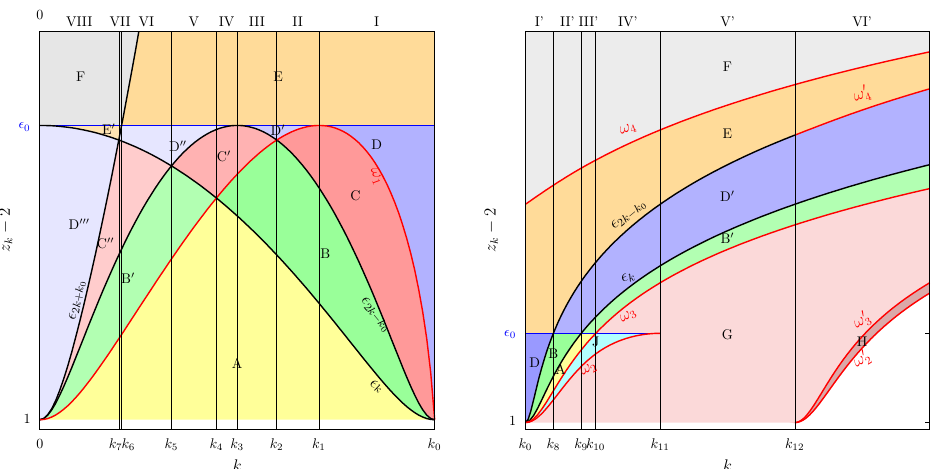
Figure 13: Diagram of the resonance superconfigurations for k ≤ k (left panel) and 0 k ≥ k (right panel). The configurations denoted by Roman letters (see Tab. 2 for 0 their signification) are shown in colors and delimited by energy lines shown in solid = (cid:113) k 2 + 1, in red the energies ω curves: in black ε , ε and ε , in blue ε k i 2 k − k 0 2 k + k 0 0 0 listed in Tab. 6 (note that ω and ω (cid:48) continue ε and ε respectively at k > k 4 2 k + k 0 2 k − k 0 0 4 and k > k ). The vertical lines delimit the k -intervals where the same succession of 12 configurations is found when increasing z from 3 to + ∞ . To each sector between k two vertical lines corresponds a diagram similar to Fig.